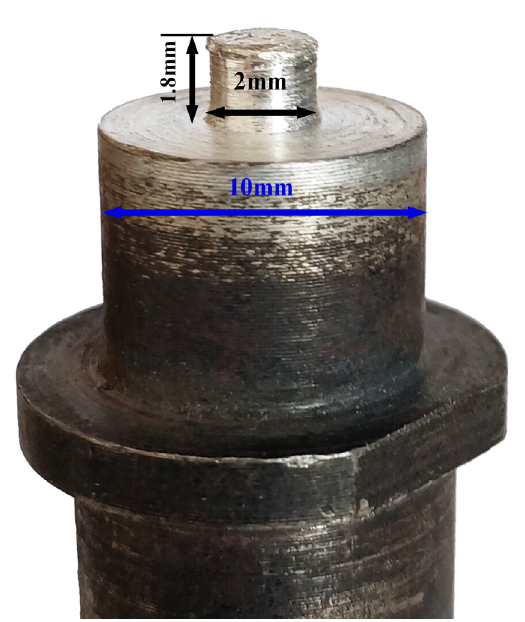
Figure 1. Photo of the welding